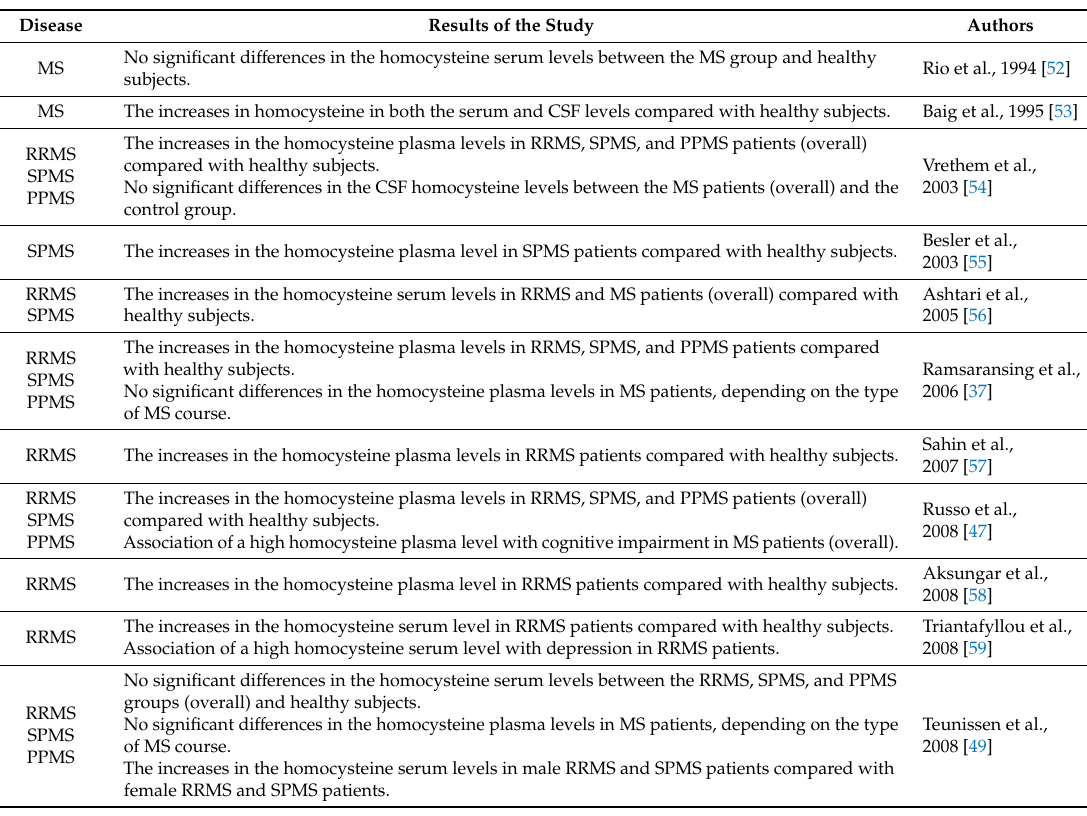
Table 1. Data of the main studies of homocysteine level in relapsing-remitting multiple sclerosis